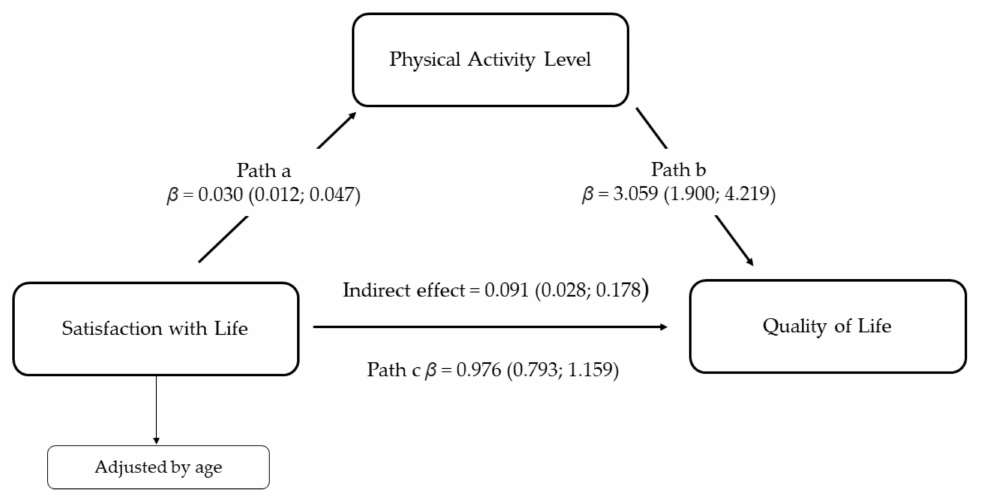
Figure 1. Simple mediation analysis of the effect of satisfaction with life on HRQoL mediated by physical activity level. This model was adjusted by age and the number of bootstrap samples was 5000. Path a = association between satisfaction with life and physical activity level; Path b = associa- tion between physical activity level and HRQoL; path c = direct effect of the satisfaction with life and